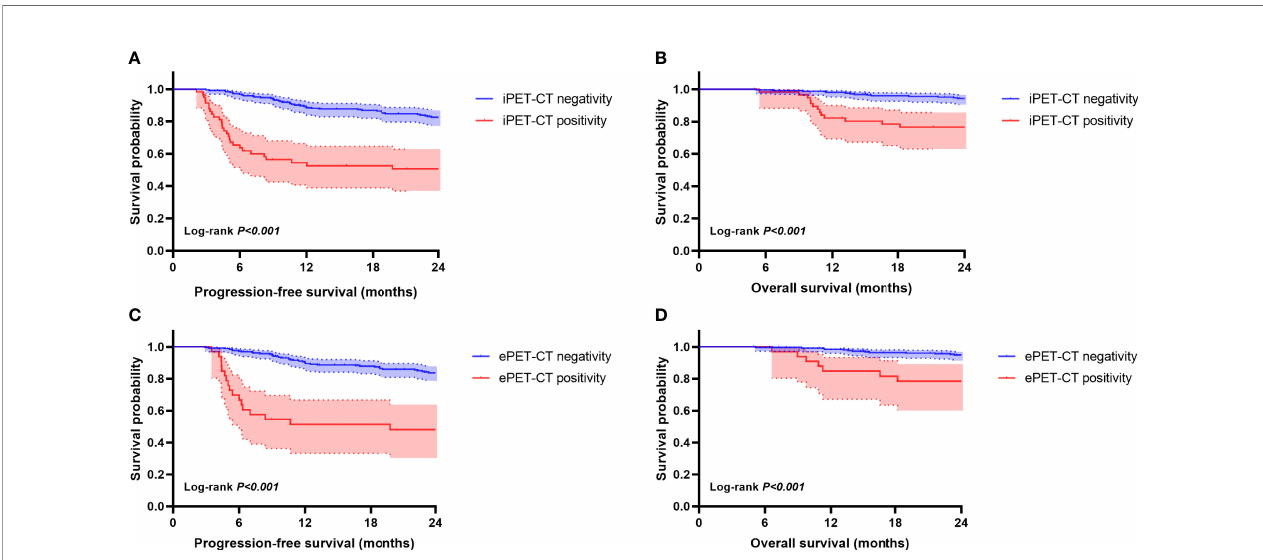
FIGURE 2 | Kaplan-Meier survival curves according to interim PET-CT (iPET-CT) and end-of-treatment (ePET-CT). Progression-free survival (PFS) (A) and overall survival (OS) (B) according to iPET-CT evaluation. PFS (C) and OS (D) according to